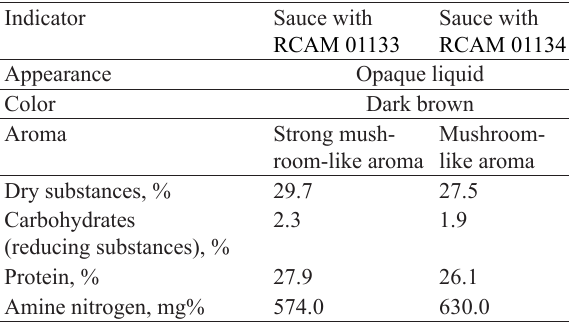
Table 2 Sensory and physicochemical indicators of the fermented sauces based on Aspergillus